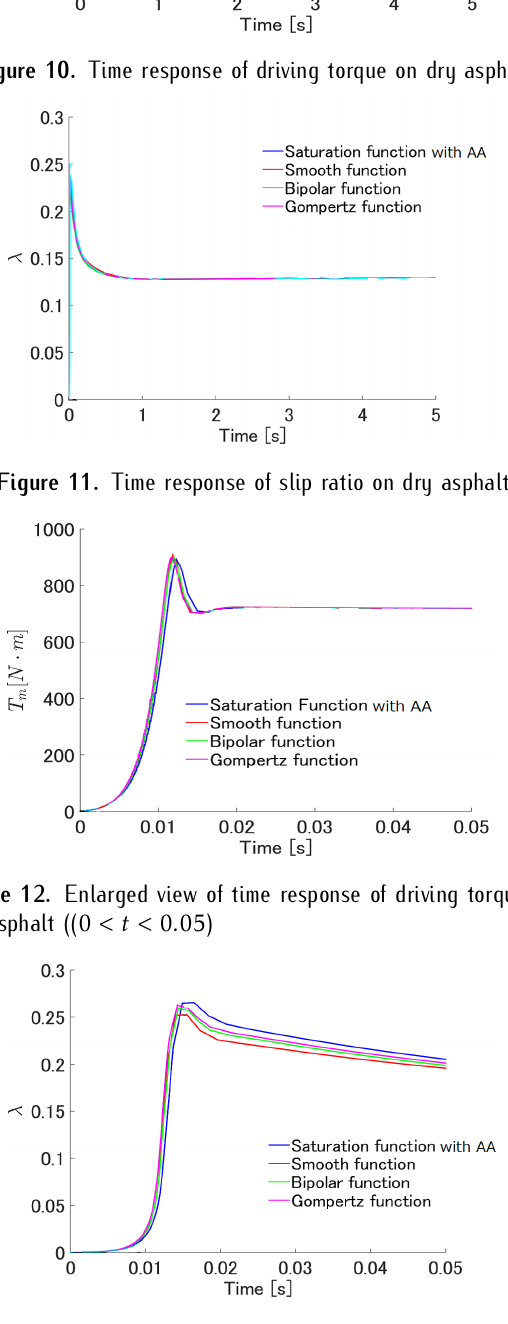
Figure 13. Enlarged view of time response of slip ratio on dry asphalt (( 0 < t < 0 : 05 )